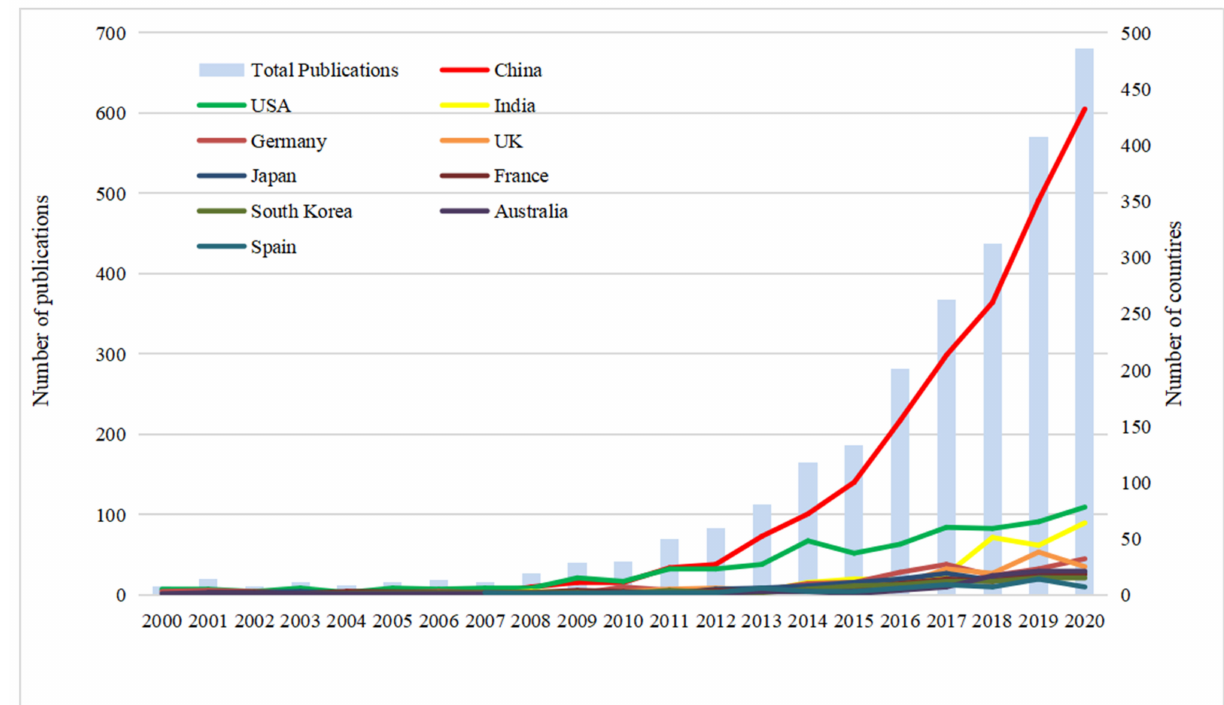
Figure 1. The number of publications of energy storage ceramics research by year.